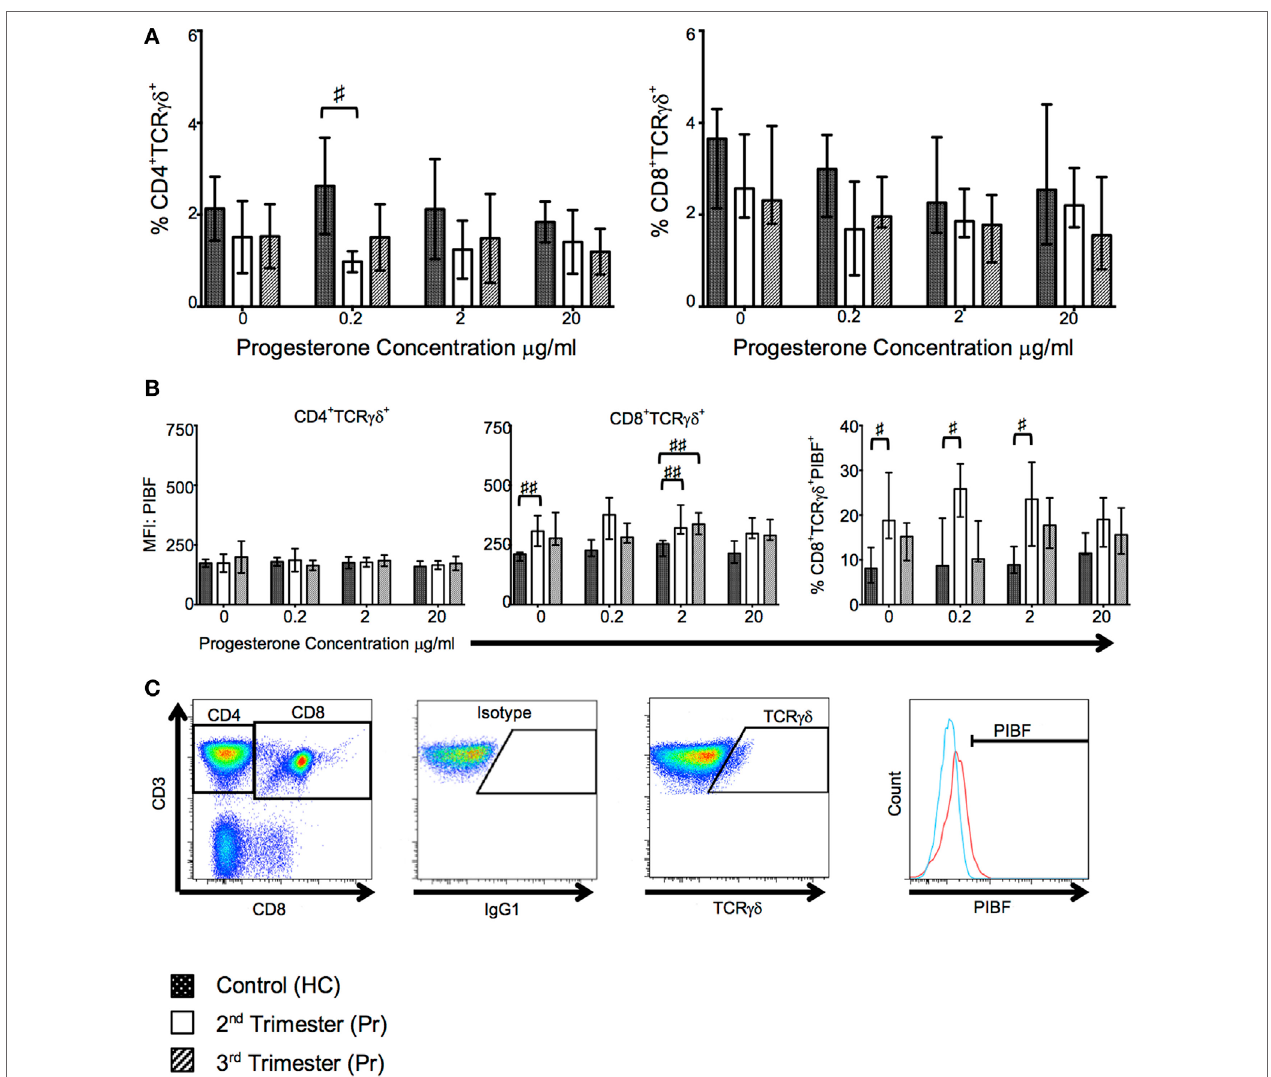
FigUre 6 | T cell receptor (TCR)- γδ + T-cell proportions are reduced in pregnancy but they express greater progesterone-induced blocking factor (PIBF). These changes are primarily seen in the second trimester. (a) Shows changes in proportions of TCR- γδ CD4 and CD8 T cells in response to progesterone culture. (B) Alterations in PIBF expression on the aforementioned TCR- γδ T cells. (c) Peripheral blood mononuclear cell (PBMCs) were surface stained with anti-CD3, anti-CD8, anti-TCR- γδ , and anti-PIBF. Gating strategy used to phenotype CD4 + /CD8 + TCR- γδ + PIBF + T-cells. Box and whiskers plots indicate median, interquartile range and 10th–90th centiles. ♯ p < 0.05 and ♯♯ p < 0.01 (Kruskal–Wallis one way analysis of variance and Dunn’s test for multiple comparisons). Abbreviations: HC, healthy control; Pr,